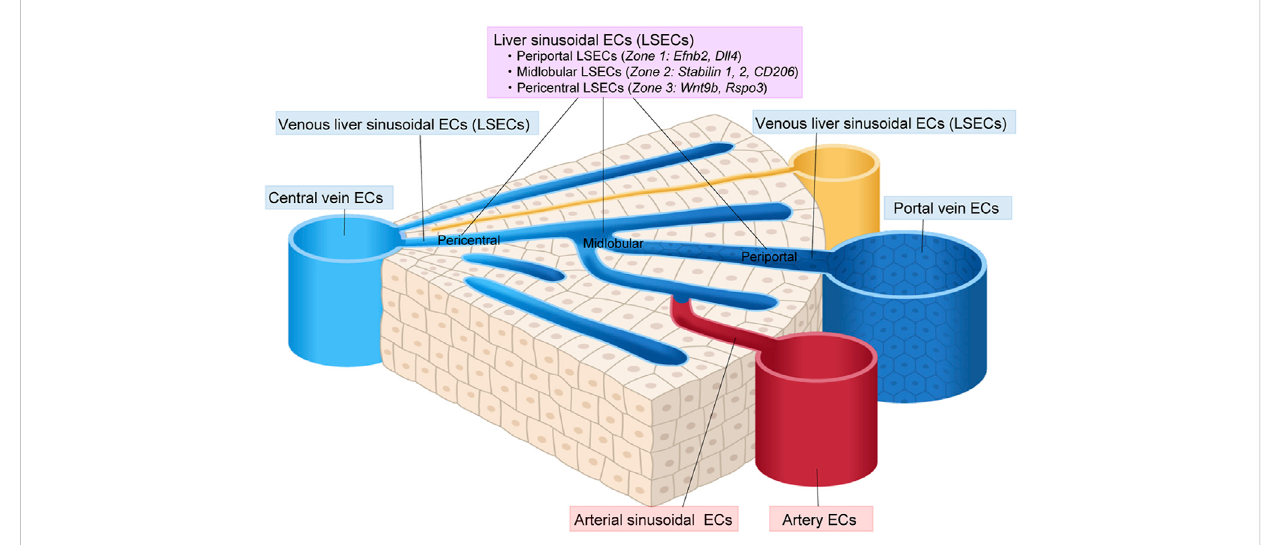
FIGURE 6 Vascular endothelial cell heterogeneity in the liver. Vascular endothelial cells (ECs) in the liver show diverse heterogeneity. Liver sinusoidal ECs (LSECs) can be classi fi ed into periportal, midlobular, and pericentral